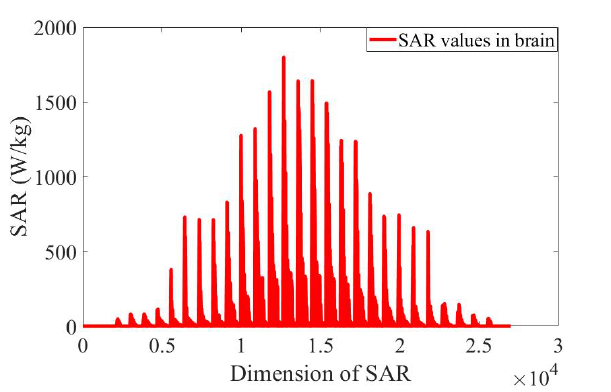
Figure 7. Specific absorption rate (SAR) values in brain transformed into one-dimensional